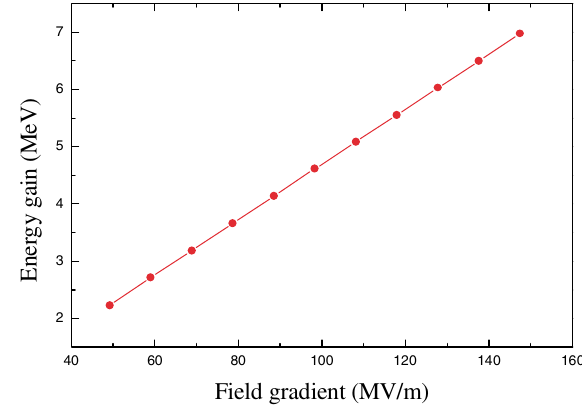
FIG. 8. (Color) Energy gain vs peak accelerating field gradient simulated using PARMELA .